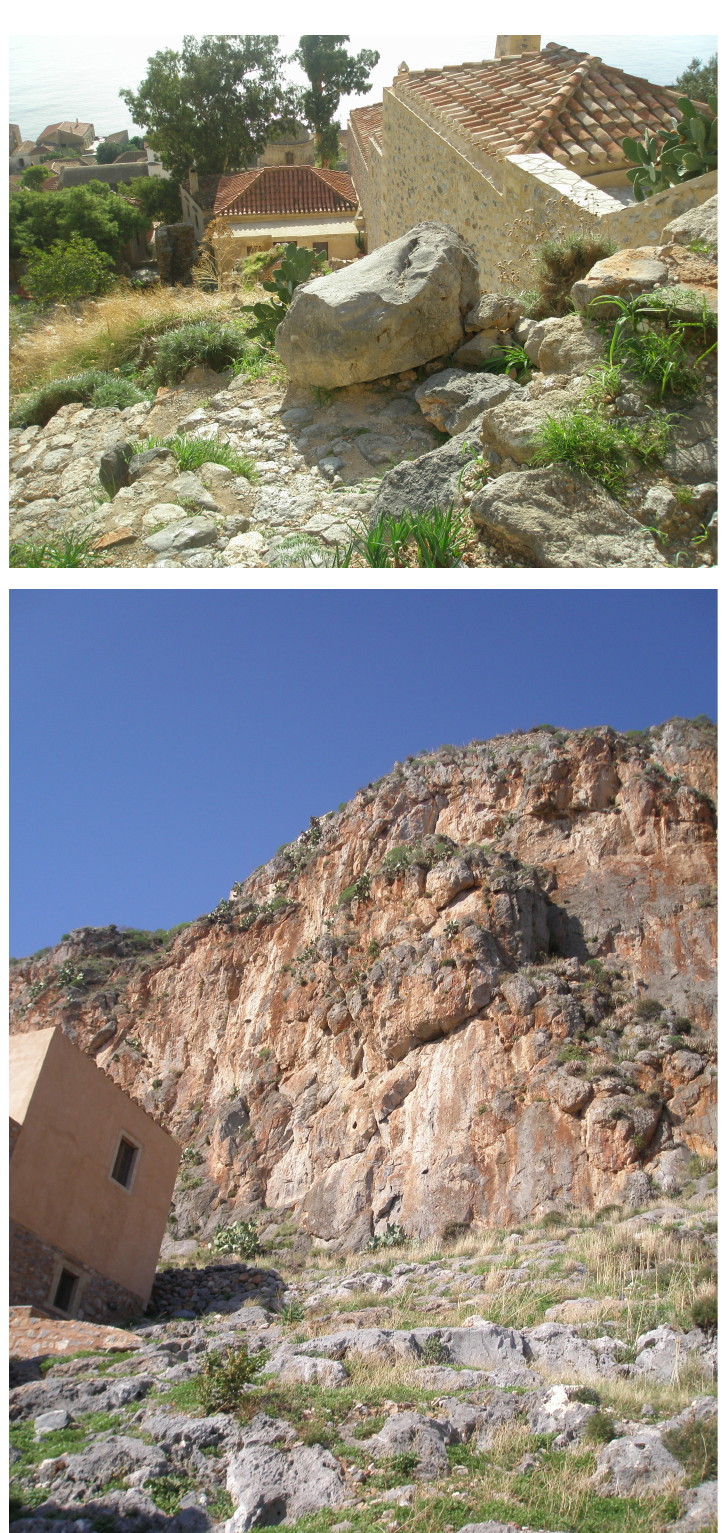
Fig. 3. (a) View of fallen rock blocks in area of section D (b) overhanging blocks in area of section Z. Range of volumes: 1.5 to 5m 3 .